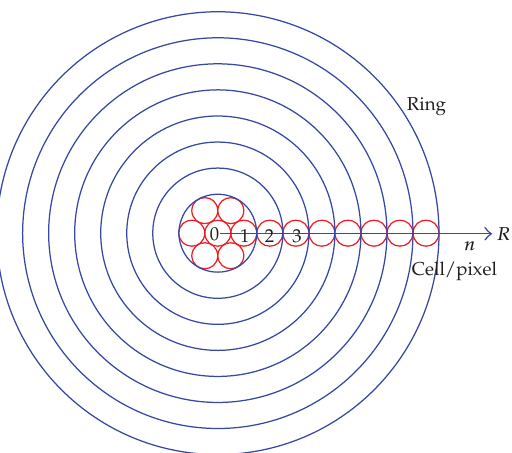
Figure 1: A sketch map of urban field with rings and